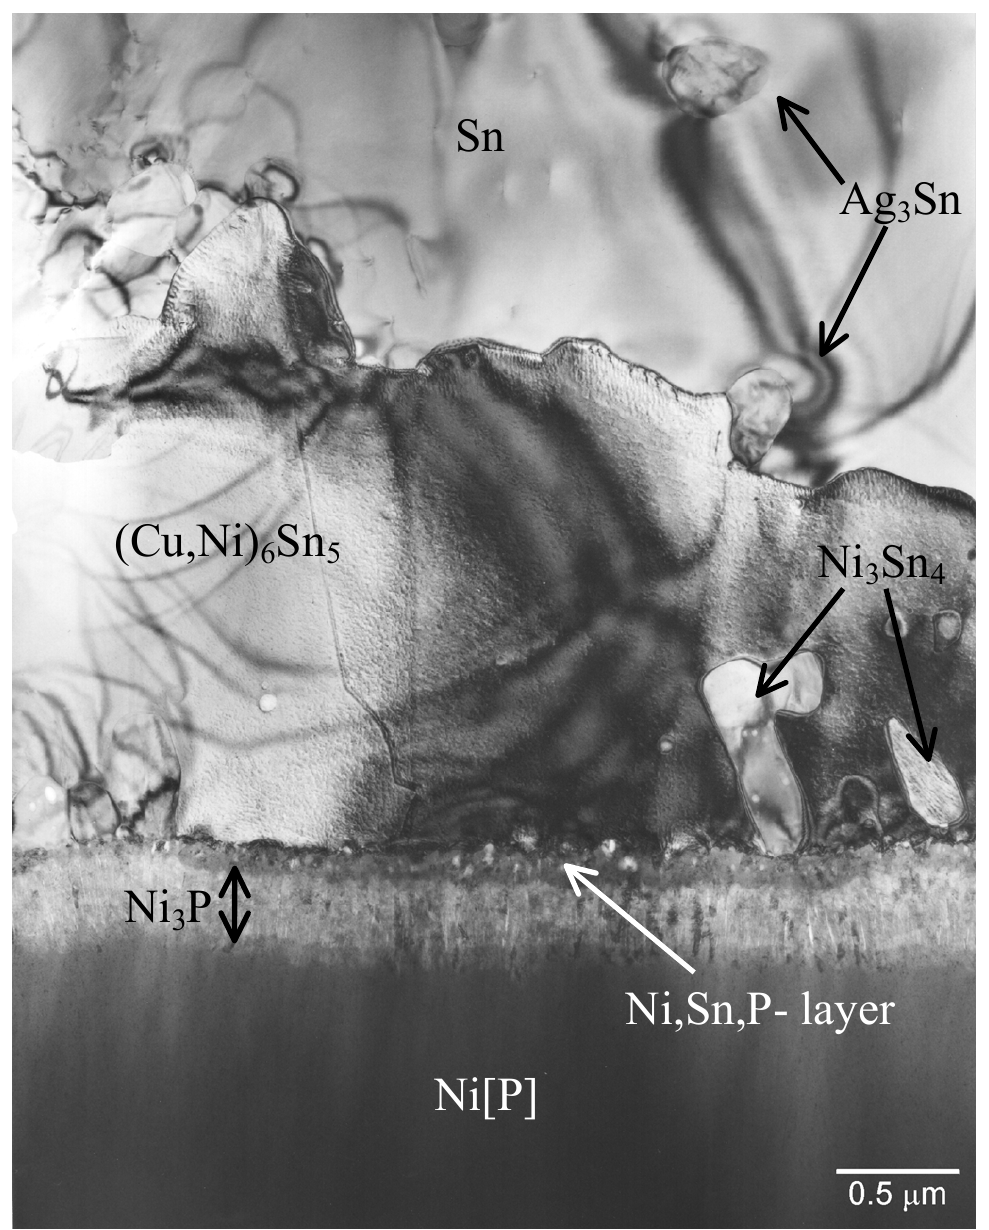
Figure 5. Bright-field TEM image of the interfacial region in the sample that have been reflowed five